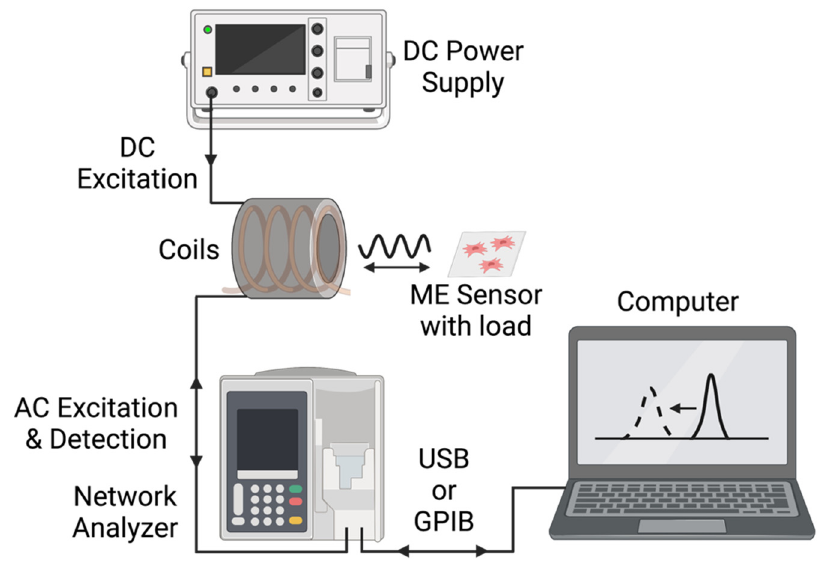
Figure 3. Block-diagram of the key instrumentation and interfaces in this experimental setup.